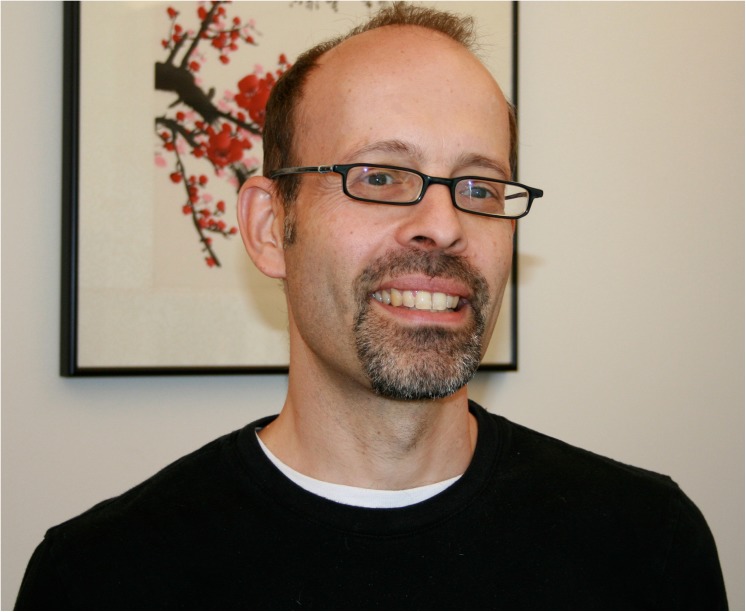
Michael S. Diamond.